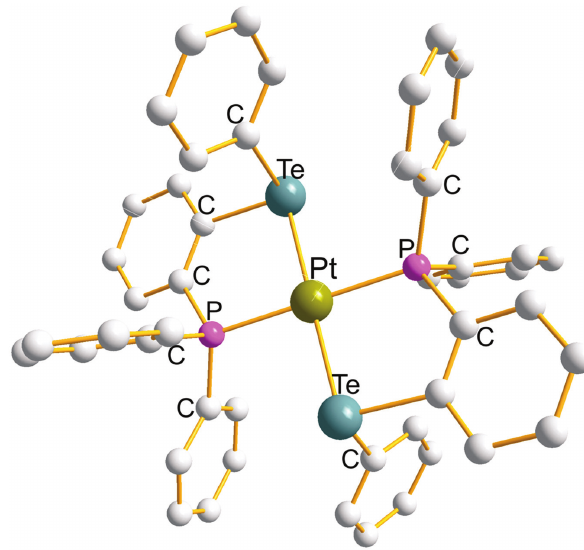
Figure 5: Structure of [Pt{η 2 -Ph